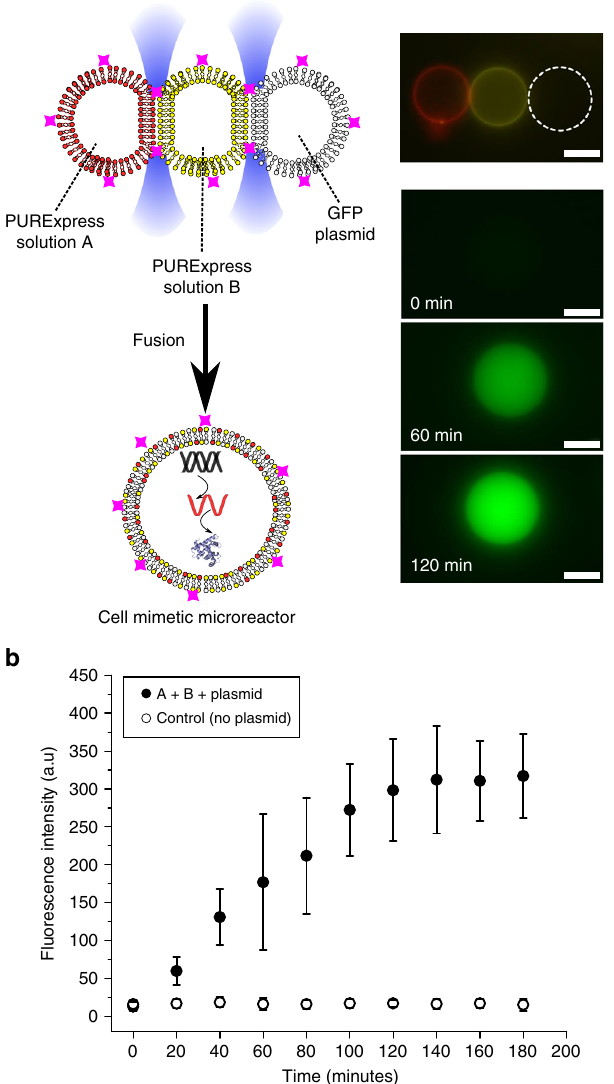
Fig. 9 Vesicle fusion to initiate biochemical reactions in a cell-mimetic compartment. a Schematic and fl uorescence microscopy images of a three- vesicle network containing the different components needed for cell-free protein expression. Red = Cy5-PE lipid, yellow = Rh-PE lipid. Dotted white circle represents unlabelled vesicle. Vesicles were fused with a laser, leading to GFP synthesis (green channel). Scale bar = 5 µ m for all images. b Graph showing an increase in mean fl uorescence following fusion as GFP is being synthesised (error bars = 1 s.d, n =